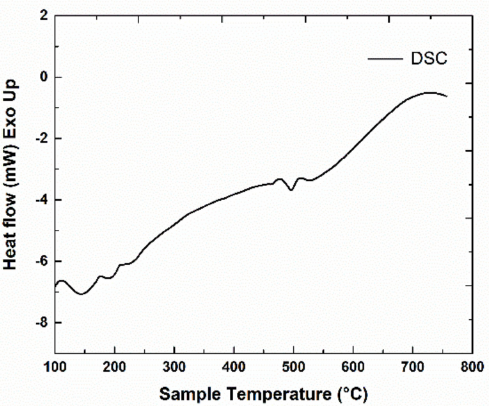
Figure 1. Differential scanning calorimetry (DSC) scan for Mn 53 Al 45 C 2 sample.